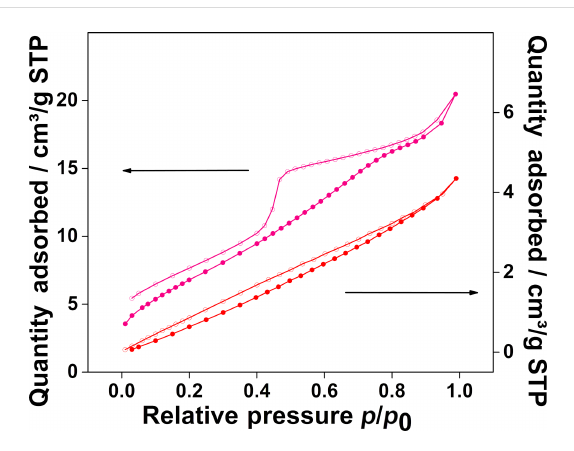
Figure 4: Nitrogen sorption isotherms of the synthesized composite electrode with nitrogen doping (upper line) and the carbonized carbon felt (lower line).